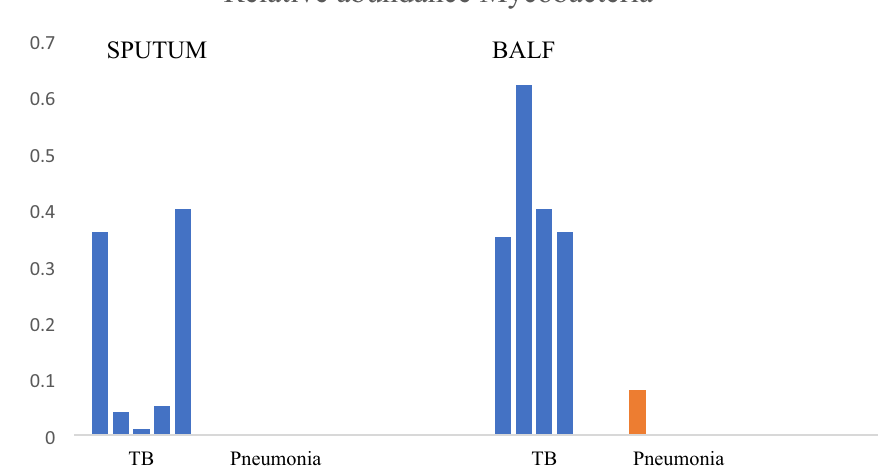
Figure 3. Relative abundance of mycobacteria in the various cohorts: HIV, Pneumonia and TB in sputum and in BALF.